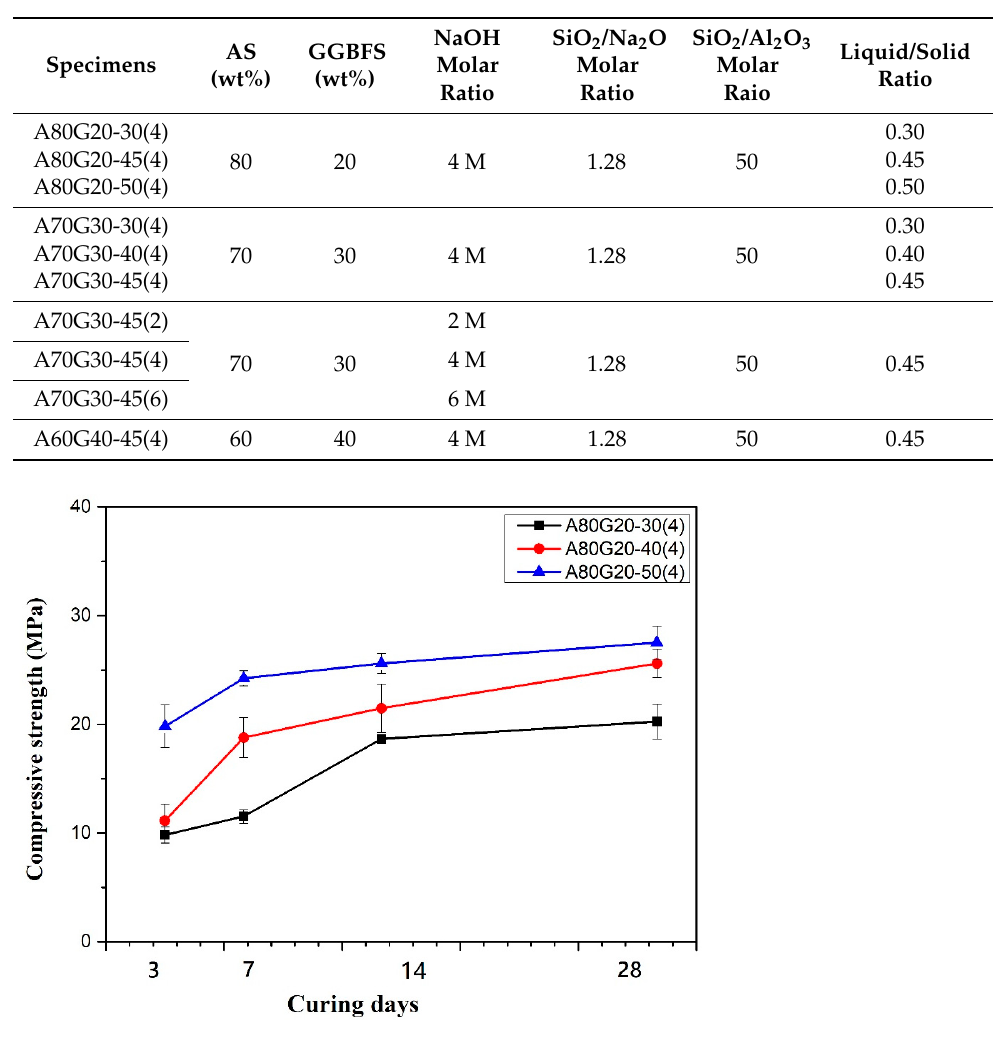
Figure 4. Influence of L/S ration on the compressive strength of A80G20-geopolymer mortar.